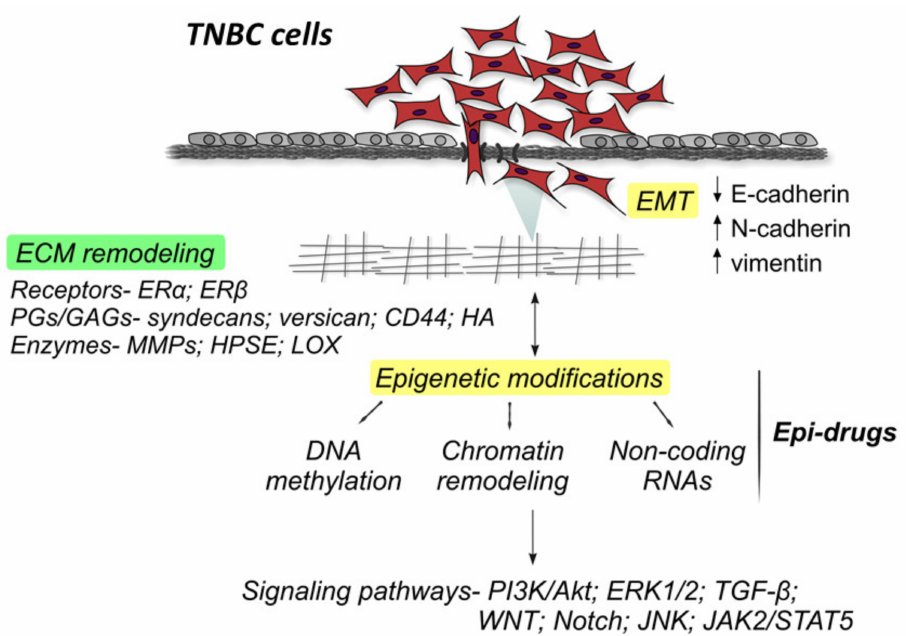
Figure 1. The extracellular matrix (ECM) components that participate in triple-negative breast carcinoma (TNBC) pro- gression include among others major epithelial-to-mesenchymal transition (EMT) biomarkers (E-cadherin, N-cadherin, vimentin, TGF- β etc.), matrix enzymes (matrix metalloproteinases (MMPs), heparanase (HPSE), LOX, HASes, etc.), pro- teoglycans/glycosaminoglycans (syndecans, CD44, HA etc.), miRNAs (let-7, miR-7, miR-10b, miR-27a, miR-145, miR-200, miR-203 etc.) and estrogen receptors (ER α / β ), that affect the activation of signaling pathways critical for the control of TNBC cell properties (PI3K/AKT, ERK1/2, JNK, Src, JAK2/STAT5, WNT, Notch